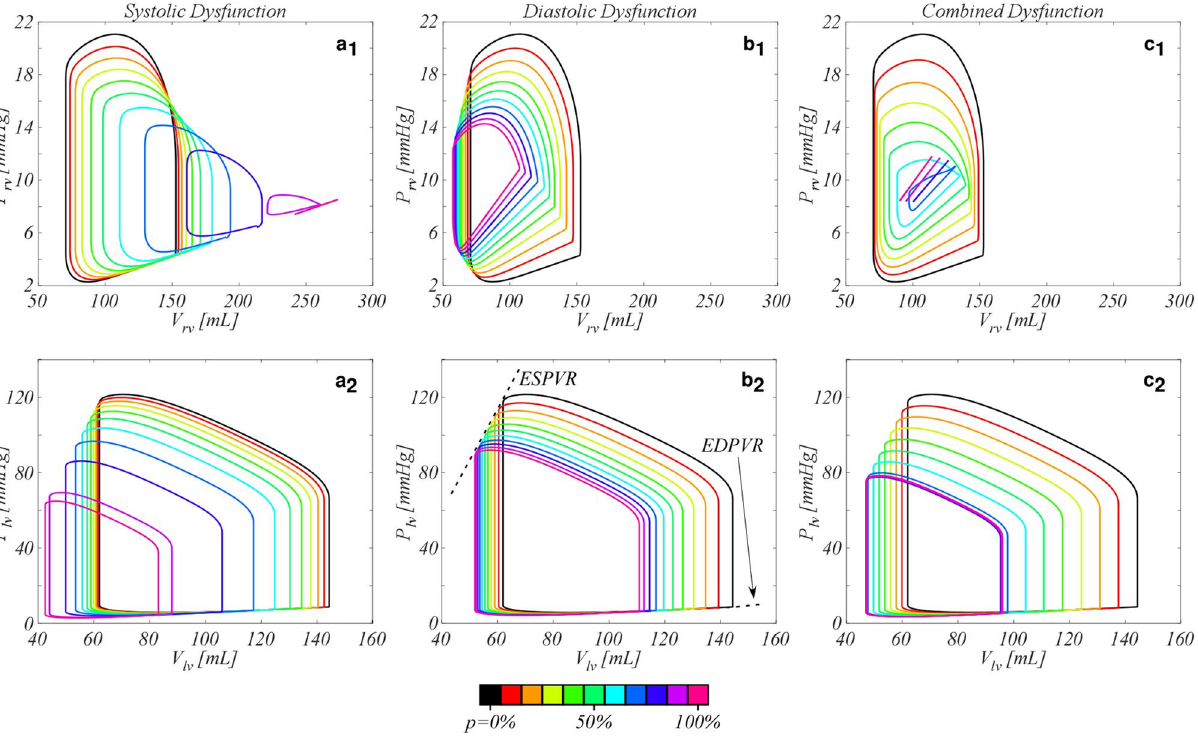
Figure 4. Pressure–volume loops for RV (subscript 1) and LV (subscript 2). ( a ) Systolic dysfunction; ( b ) diastolic dysfunction, and ( c ) combined systolic and diastolic dysfunction. Black solid line, healthy configuration ( p = 0%); coloured lines; the corresponded degree of right ventricle (RV) impairment, p , from 10 to